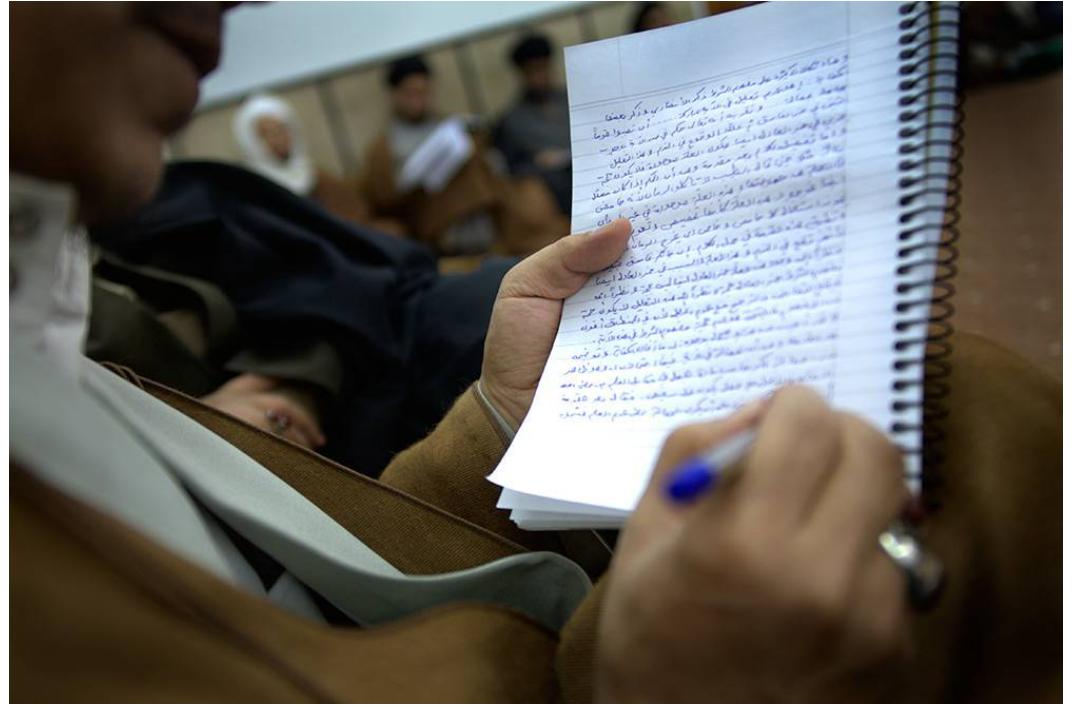
Figure 4. Designed photograph. All materials © Massimiliano